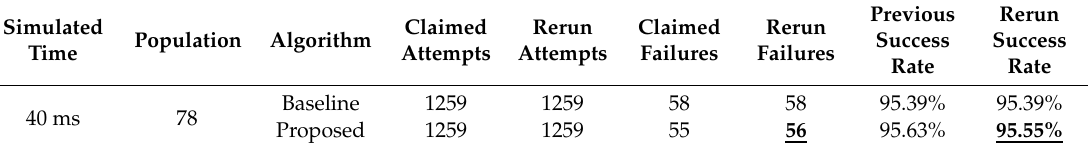
Table 6. Inconsistencies in results.